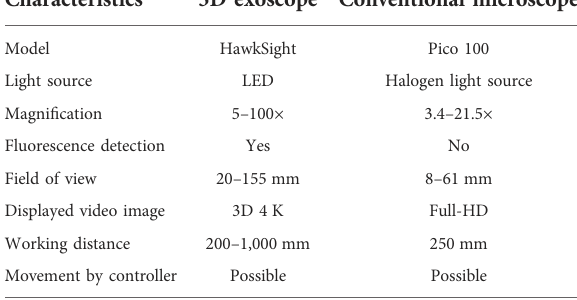
TABLE 1 Comparison of technical speci fi cations between the 3D exoscope and conventional microscope. Characteristics